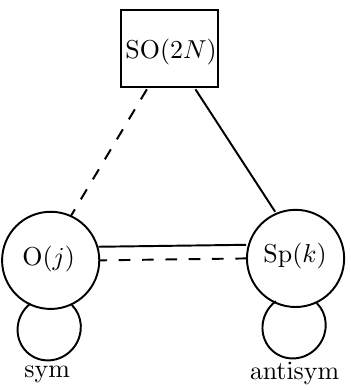
Figure 7 . The solid line represents a hypermultiplet while the dashed line represents a Fermi